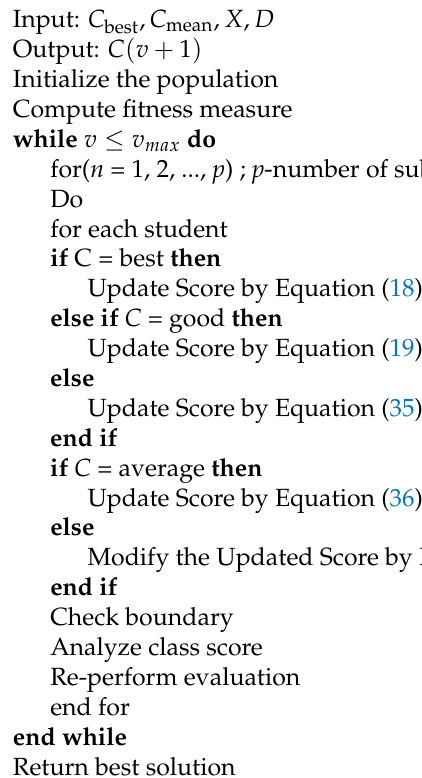
Algorithm 1 Pseudo code of proposed SPWO algorithm